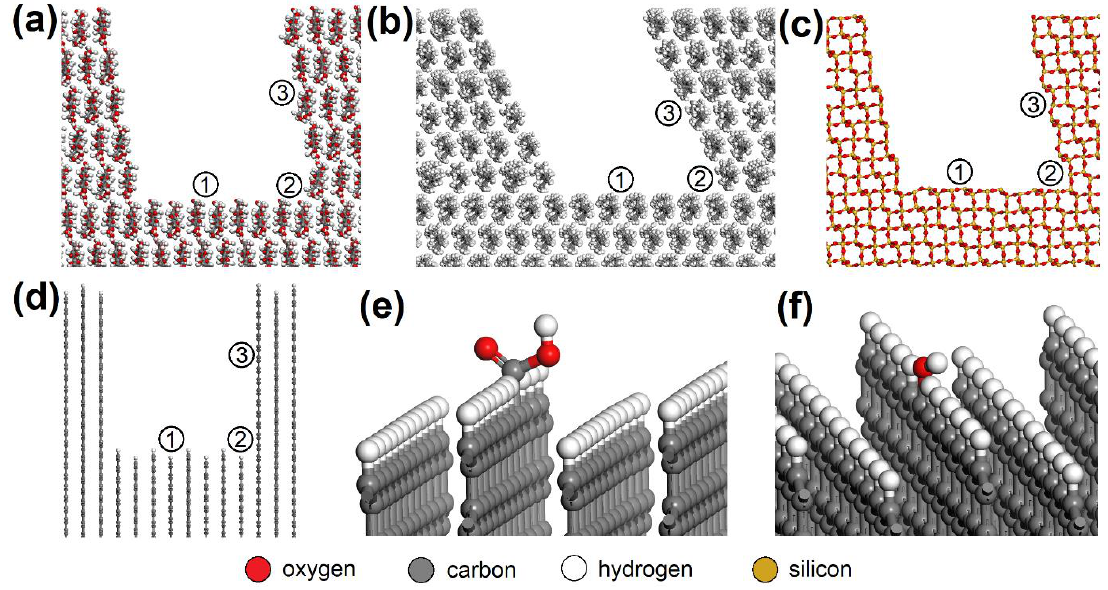
Figure 3. Nanopores in the ( a ) CEL, ( b ) PP, ( c ) SiO 2 , and ( d ) AC surfaces with spots where the NO or SO 2 molecule was placed: (1) bottom, (2) corner, (3) side. NO or SO 2 molecules were also placed on the AC surfaces with -COOH or -OH groups added, e.g. ( e ) bottom_COOH and ( f ) bottom_OH. CEL — cellulose, PP — polypropylene, SiO 2 — silicon dioxide, AC — activated carbon. Due to the XPS analysis of AC adsorbents establishing 3.67 % carboxyl and 4.61 % hydroxyl groups on the surface, models with -COOH (bottom_COOH, corner_COOH, cavity_COOH) and -OH (bottom_OH, corner_OH, cavity_OH) added to the bare AC sur- faces (bottom, corner, cavity) were also prepared (Figure 3e,f). The main advantage of using this approach to building AC models based on a graphitic structure is the possibility it offers of creating pores and cavities of controllable sizes [43].